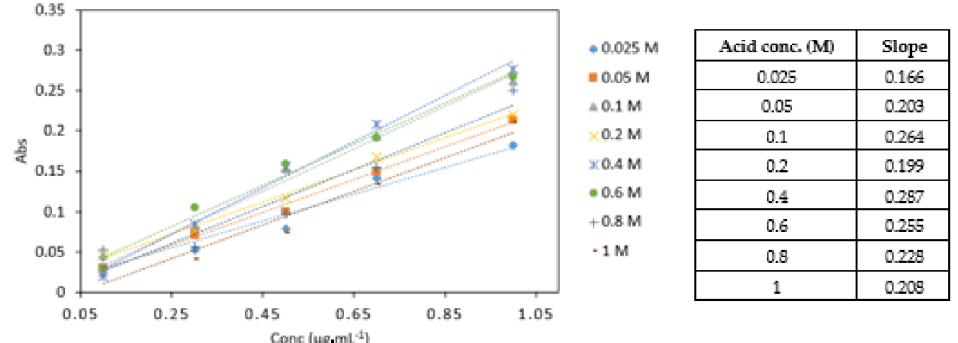
Figure 7. A comparison of Cr VI (0.1–1 mg · L − 1 ) analysed with various sulphuric acid concentrations (0.025, 0.05, 0.1, 0.2, 0.4, 0.6, 0.8 and 1 M). All measurements were carried out in triplicate ( n = 3).